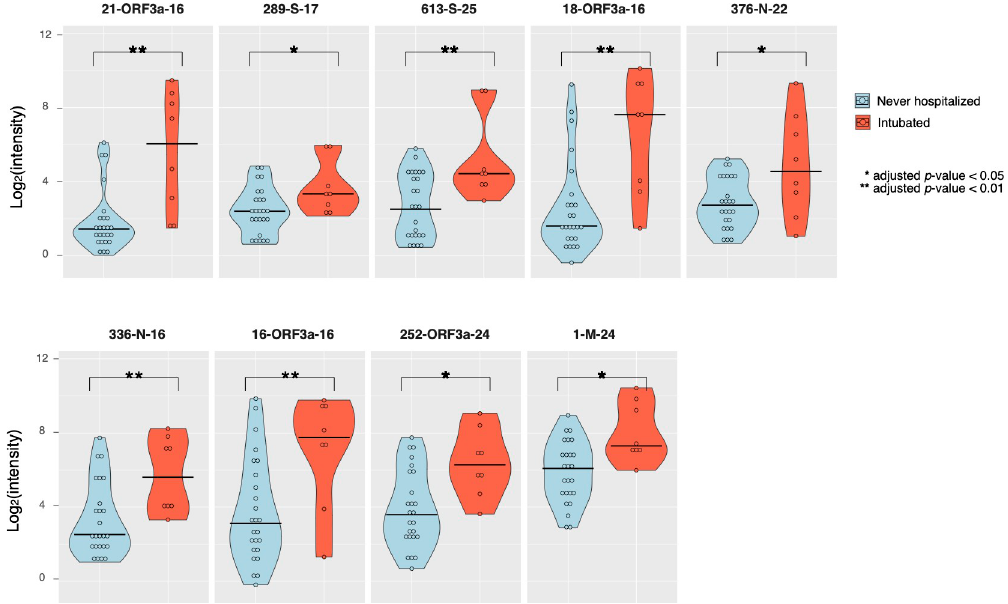
Fig 7. Disease severity correlates with increased antibody binding in specific SARS-CoV-2 epitopes. IgG reactivity against SARS-CoV-2 epitopes identified by peptide microarray in COVID-19 convalescent patients who were never hospitalized versus intubated patients showed statistically significant increases in reactivity in intubated patients for 11 epitopes. The data used in this analysis can be accessed online at: https://github.com/Ong-Research/UW_Adult_Covid-19. COVID-19, coronavirus disease 2019; IgG, immunoglobulin G; SARS-CoV-2, severe acute respiratory syndrome coronavirus 2.